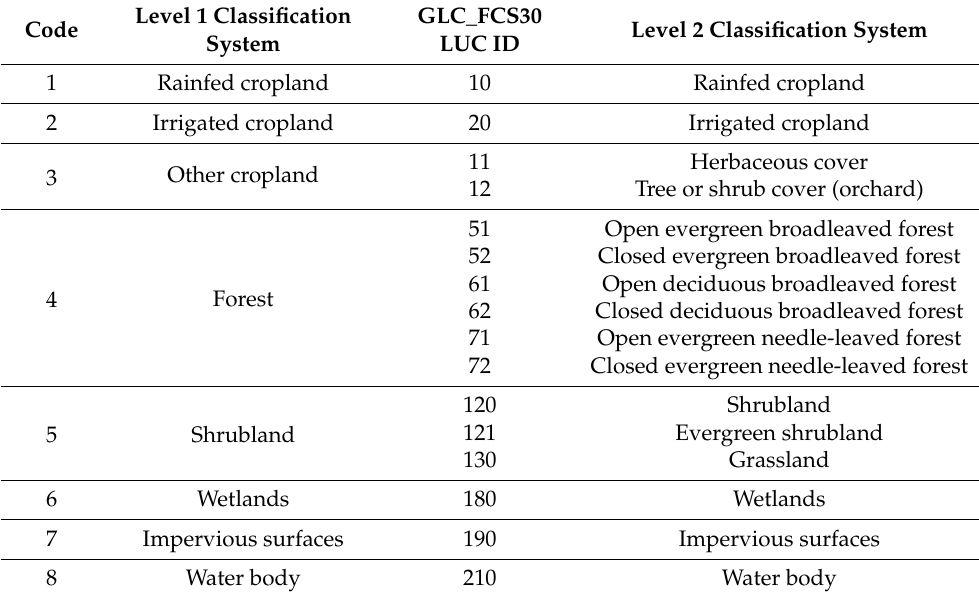
Table 2. Land use/cover classification system in Cambodia.